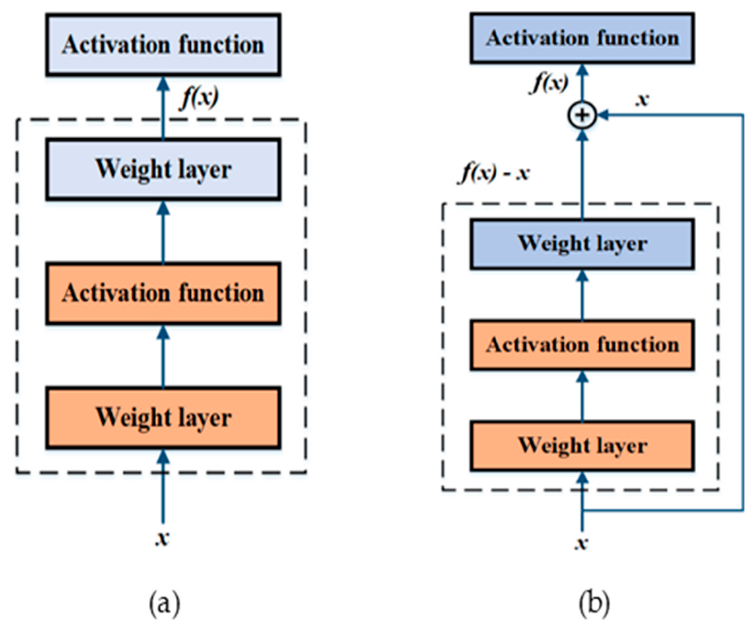
Figure 3. ( a ) Normal block and ( b ) residual block.